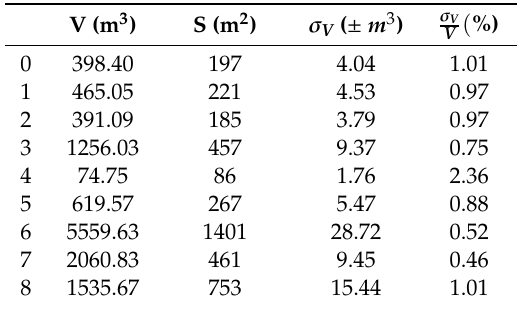
Table 8. Computed volumes with estimates of the errors.